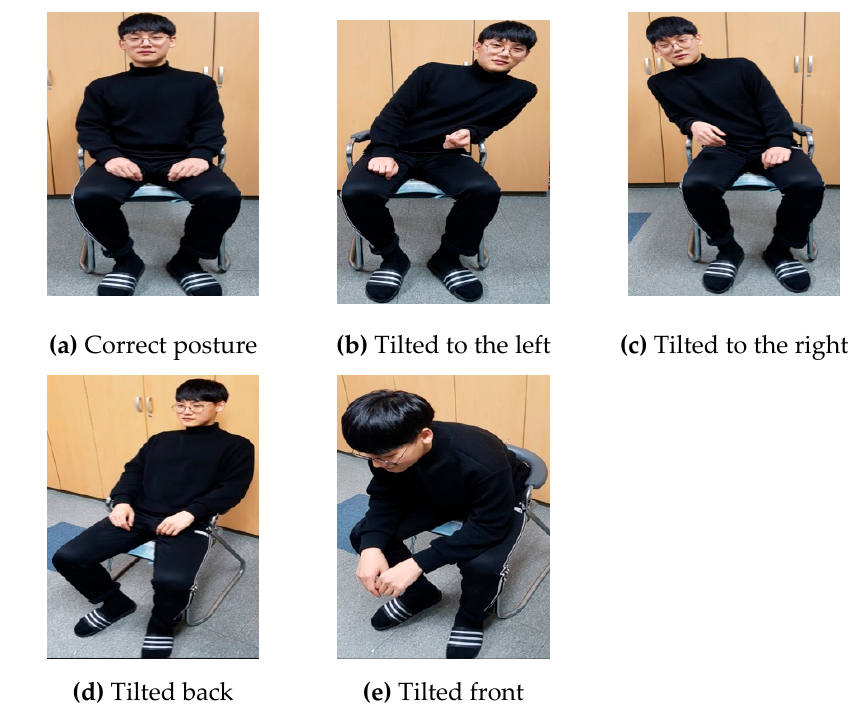
Figure 7. Five reference postures applied during the experiment. Table 2. Evaluation of the reference posture movements and determination performance of the system.